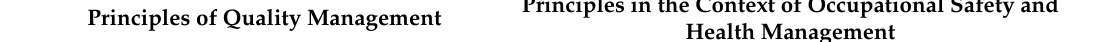
Table 3. The principles of OSH in the approach to QM